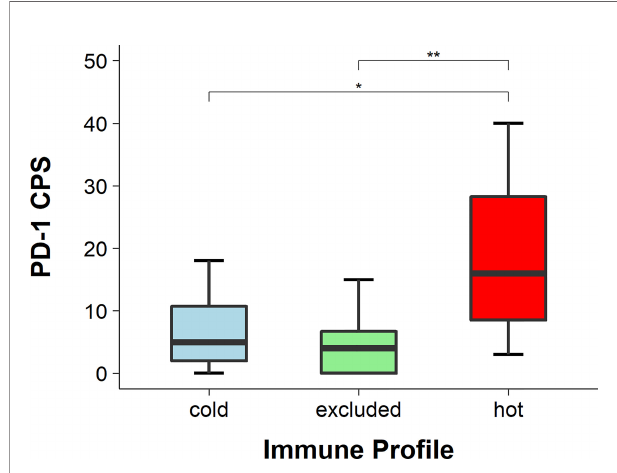
FIGURE 6 | PD-1 scores inhot, cold,and excluded head and neck squamous cellcarcinomas (HNSCCs; combined positivity score, CPS).The CPS ofPD-1 was the highest in hot tumorsand thelowest in excluded tumors, while incold tumors itwas inbetween. Thedifferences in theCPS of PD-1 betweenhot and excluded tumors and betweenhot and cold tumors were statistically signi fi cant (both p < 0.05),while thedifferencebetween cold and excluded tumors was not statistically signi fi cant ( p > 0.05), * meansp<0.05, **